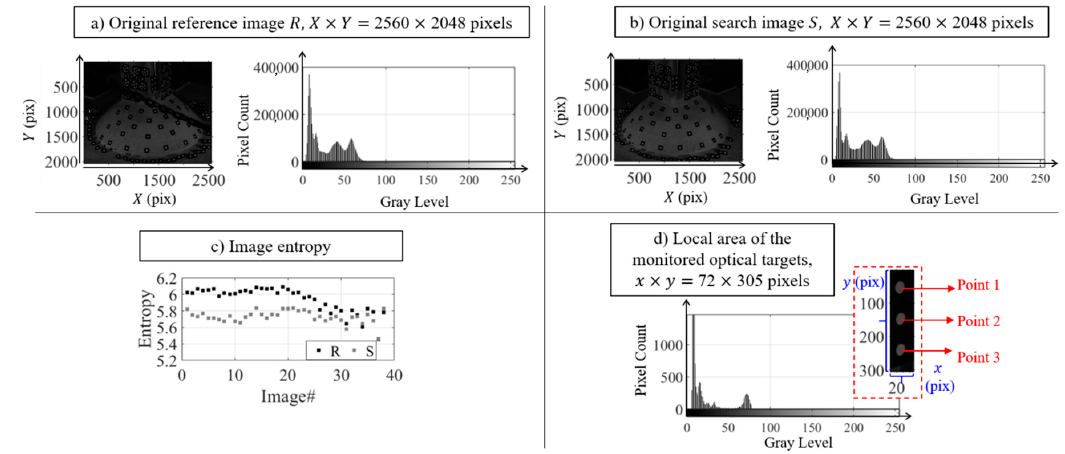
Figure 5. Sample histogram from original-size (full-resolution) images from both cameras: ( a ) reference image R , and ( b ) search image S ; ( c ) entropy of 76 photogrammetry images; and ( d ) local area x × y = 72 × 305 pixels of three optical targets, all from the one-inch block experiment. The histogram shows that most pixels have rather low intensity values that the pixel values are not distributed over the entire gray level intensity range. From the histogram, the inferred photogrammetry image information indicates that the captured image was a low-contrast image, i.e., the object being viewed was mostly dark in color and located on a dark environment. Also, the specimen was illuminated with low-intensity light. More details are observed when the image is zoomed into a local area of 72 × 305 pixels surrounding the three optical targets or points used for